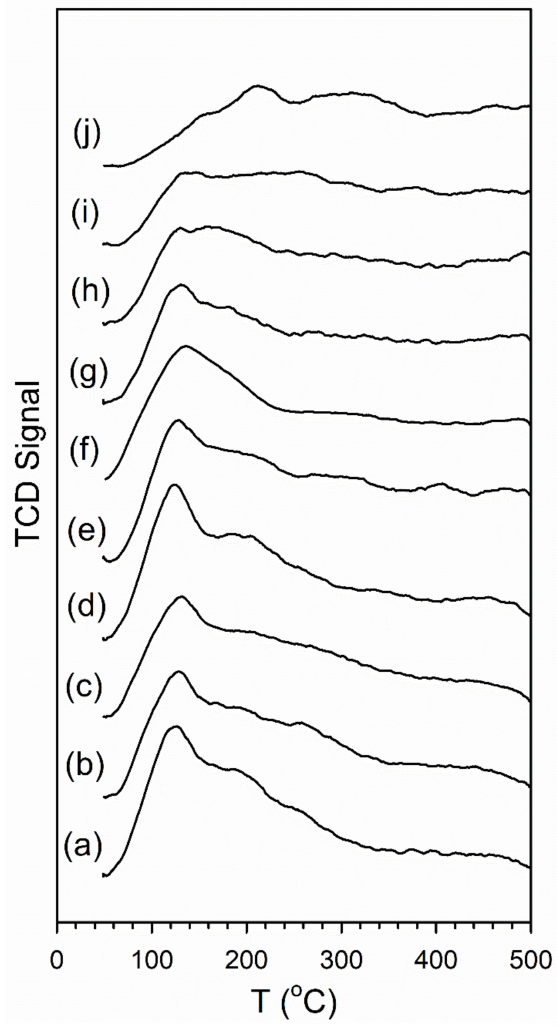
Figure 6. CO 2 temperature programmed desorption (TPD) signals of carbonate decomposition during activation for ( a ) 2%Pt/ZrO 2 , and the same doped with ( b ) 0.33%Rb, ( c ) 0.74%Rb, ( d ) 0.93%Rb, ( e ) 1.86%Rb, ( f ) 2.79%Rb, ( g ) 3.72%Rb, ( h ) 4.65%Rb, ( i ) 5.58%Rb, and ( j )